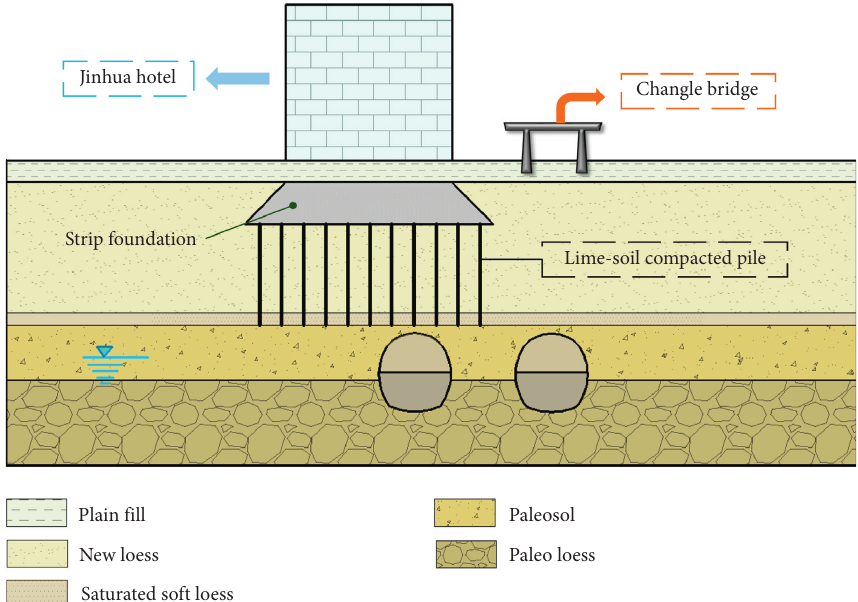
Figure 3: Vertical section of building and tunnel.